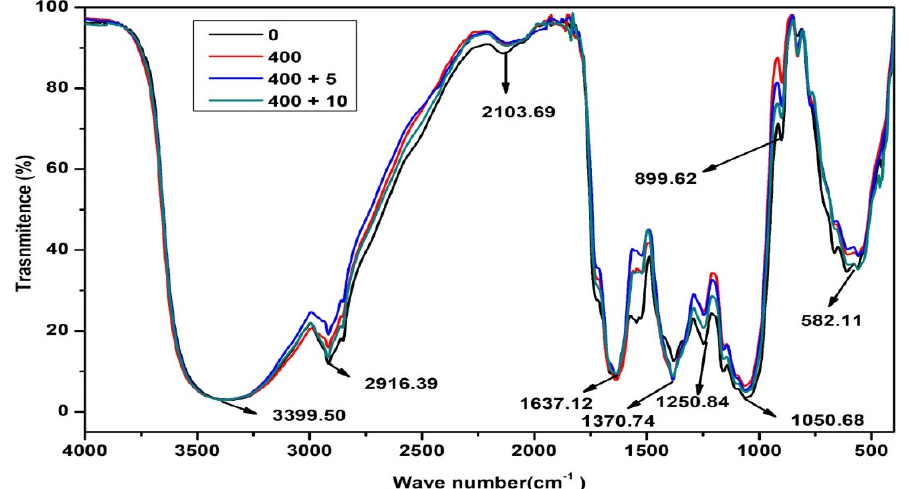
Figure 5. FTIR analysis of the effect of salt and the priming of the ZnO NPs on biomolecules in sorghum plants. Control (0 mM NaCl) plants (black), 400 mM NaCl/salt-treated (red), salt-treated plants primed with 5 mg/L ZnO NPs (blue) and 10 mg/L (green) ZnO NPs.